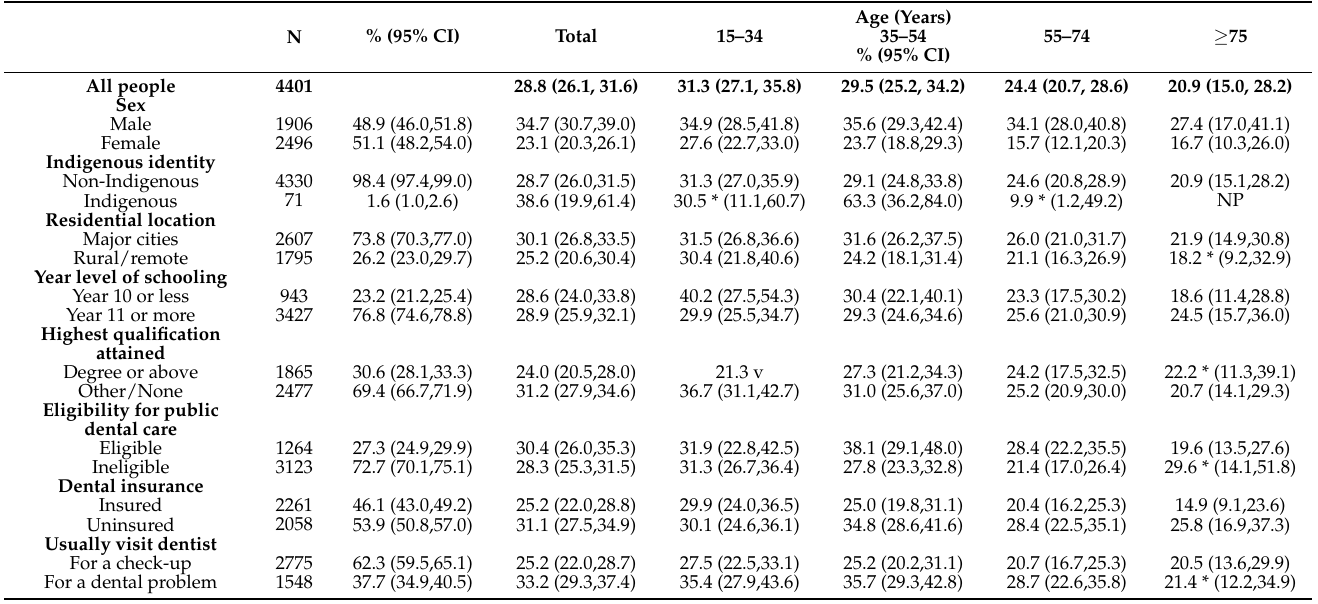
Table 4. Percentage of people with gingival inflammation in the Australian dentate population. N % (95%